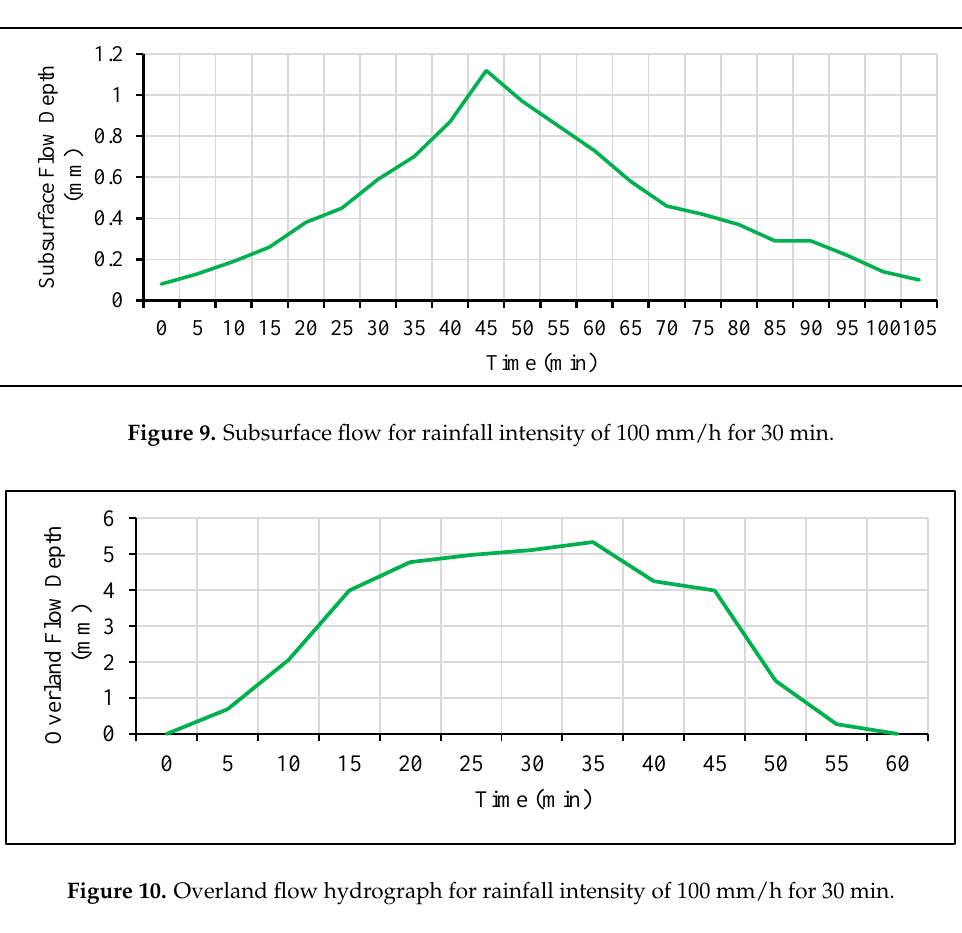
Figure 10. Overland flow hydrograph for rainfall intensity of 100 mm/h for 30 min.